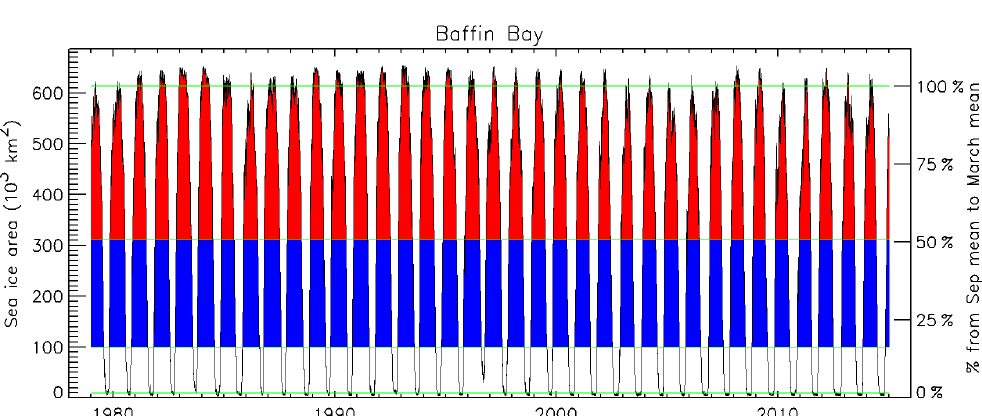
Figure 7. Sea-ice area in Baffin Bay (all depths), 1979–2014. Top green line is mean March sea-ice area; bottom green line is mean September sea-ice area. Two thresholds are shown: 15 and 50% of the way from the mean September area to the mean March